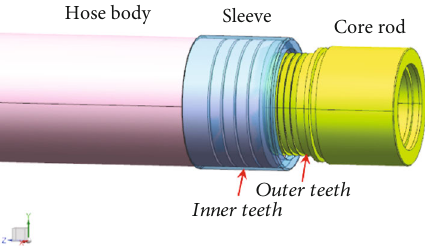
Figure 1: Schema of crimping